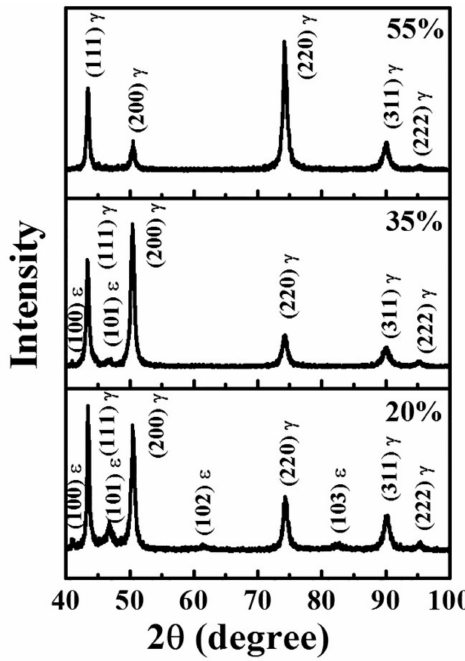
Figure 6. X-ray diffraction patterns of the specimens with different rolling reductions after tensile